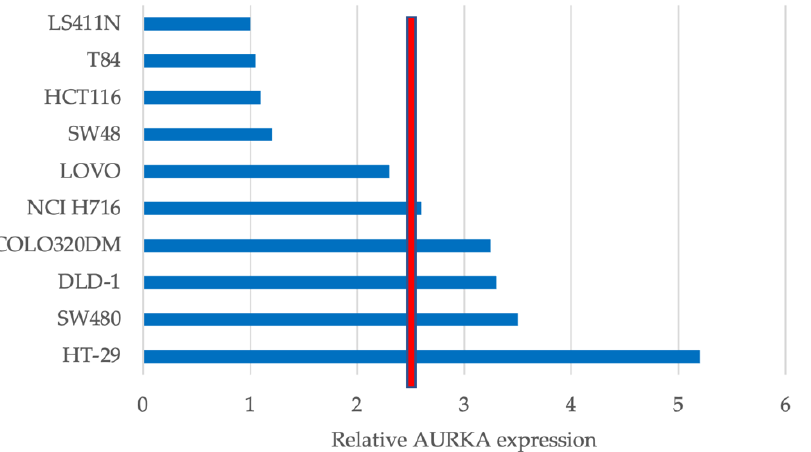
Figure 1. Relative Aurora kinase A (AURKA) expression in different colorectal cancer (CRC) cell lines. The median is represented by the red line. Based on AURKA expression, five cell lines, LS411N, T84, HCT116, SW48, and LOVO, were predicted to be non-sensitive to FTY720. NCI H716, COLO320DM, DLD-1, SW480, and HT-29 were predicted to be sensitive to FTY720.